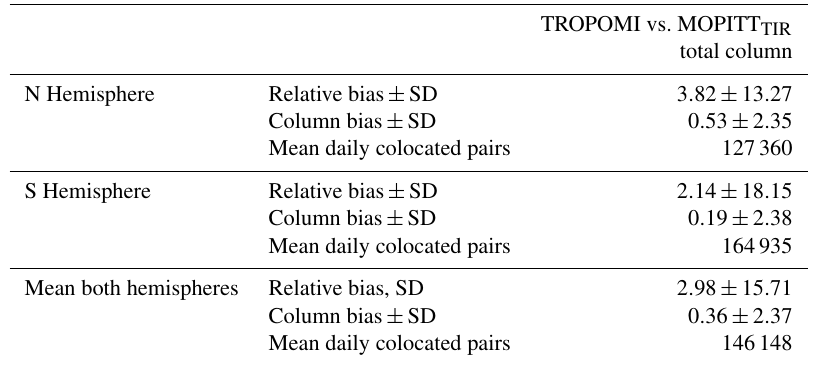
Figure 7. Map of averaged TROPOMI total CO column values acquired between 24 April and 21 May 2018, the duration of the ATom- 4 campaign. Circles show ATom-4 profiles spatially and temporally colocated with single TROPOMI retrievals; circles are color-coded according to their retrieval-simulated (smoothed) ATom total CO column value. There is good agreement between the two datasets, despite differences in the time span and footprint size each of them represents. Table 3. Colocated TROPOMI vs. MOPITT TIR CO retrievals over bodies of water: statistics performed for the period between 7 Novem- ber 2017 and 10 March 2019. Relative bias and SD are in percent. Column bias and SD are in units of 10 17 moleccm − 2